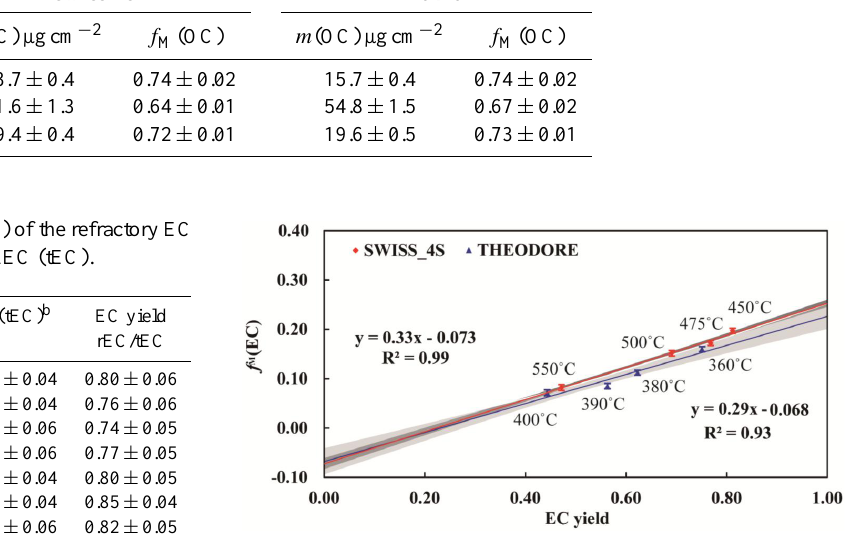
Fig. 9. Fig. 9. f M (EC) in S4 as a function of EC yield obtained by analysing the sample GOT2 with the Swiss 4S protocol and the previously used THEODORE method with different peak S2 temperatures and the oven temperatures, respectively. Shading indicates the confiden- tial interval of the linear extrapolation within 1 σ